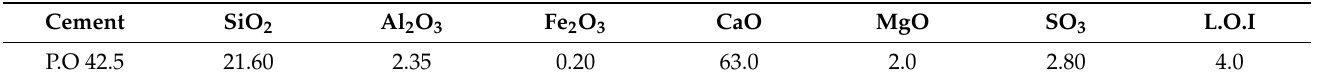
Table 2. Main chemical composition of cement